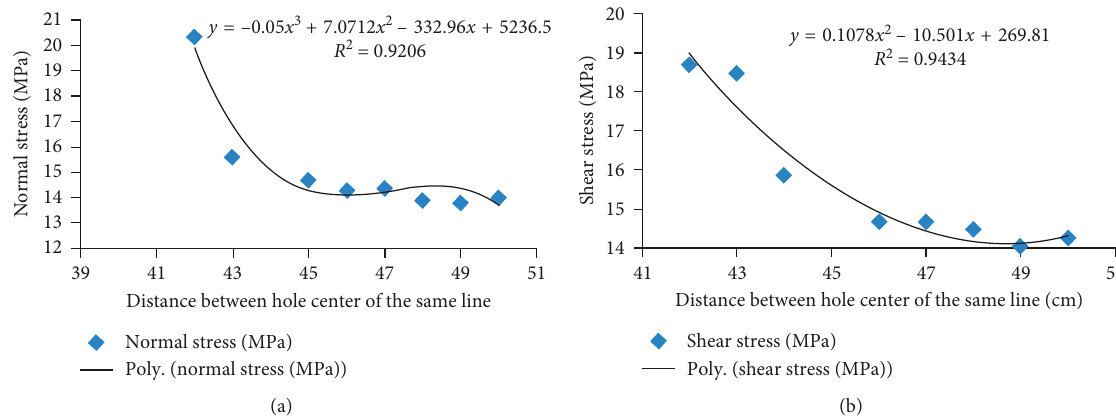
F IGURE 12: (a) Maximum of normal stress and (b) maximum of shear stress as a function of the distance between the holes of the same line in the square mesh.